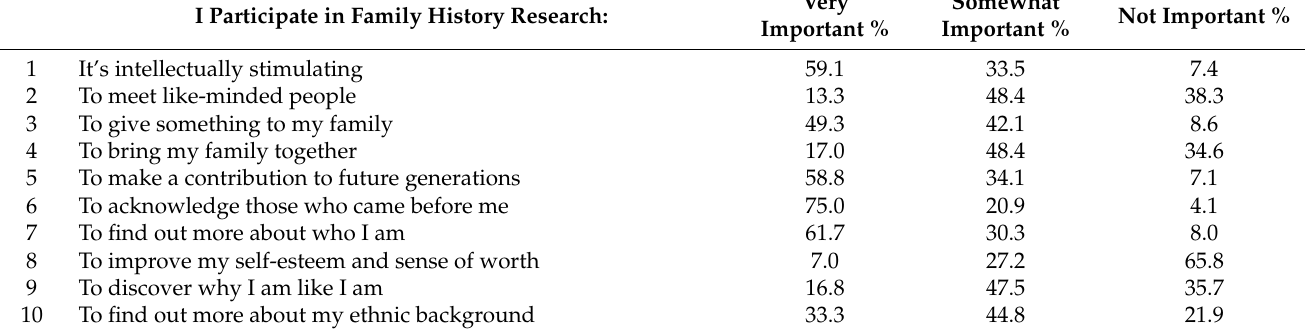
Table 1. Per cent responses to reasons for participating in family history ( N =